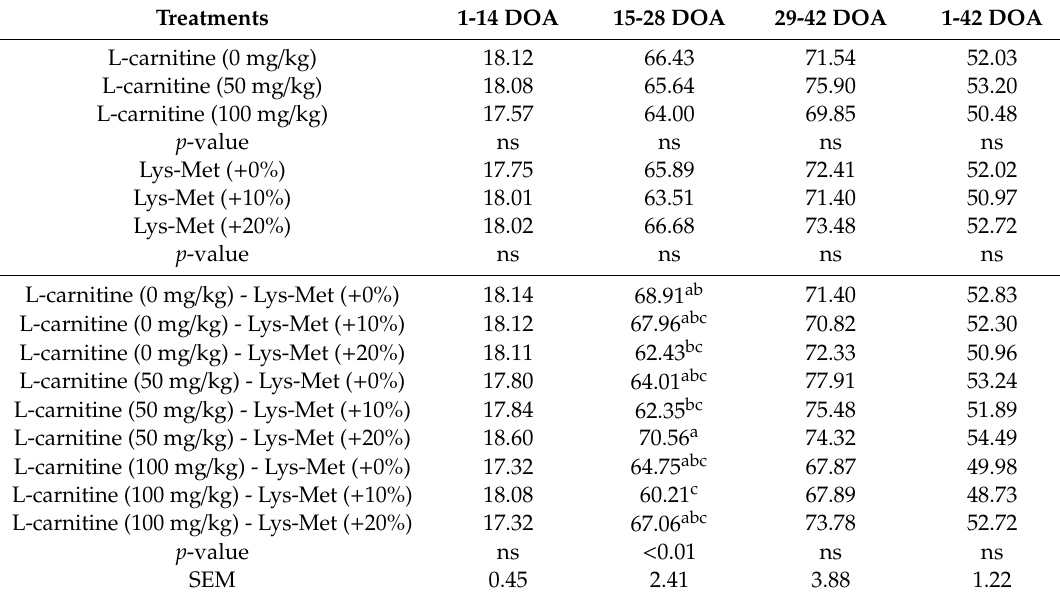
Table 3. Average body weight gain (g / day) of broilers fed di ff erent levels of L-carnitine and lysine-methionine (Lys-Met).